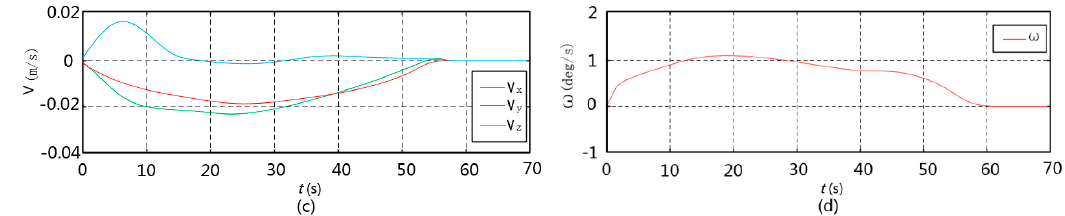
Figure 11. Visual errors of experiment A.